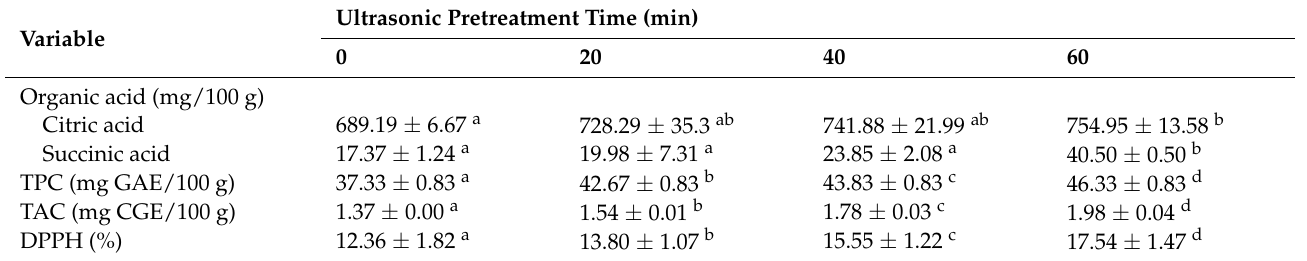
Table 2. Organic acids, phenolics, anthocyanins, and DPPH radical scavenging